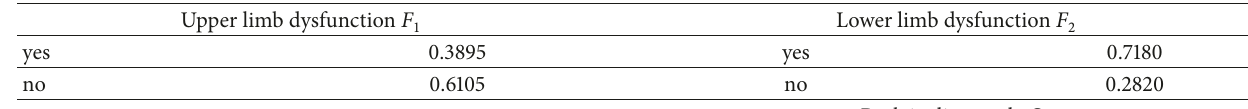
Table 4: Conditional probability distribution table.